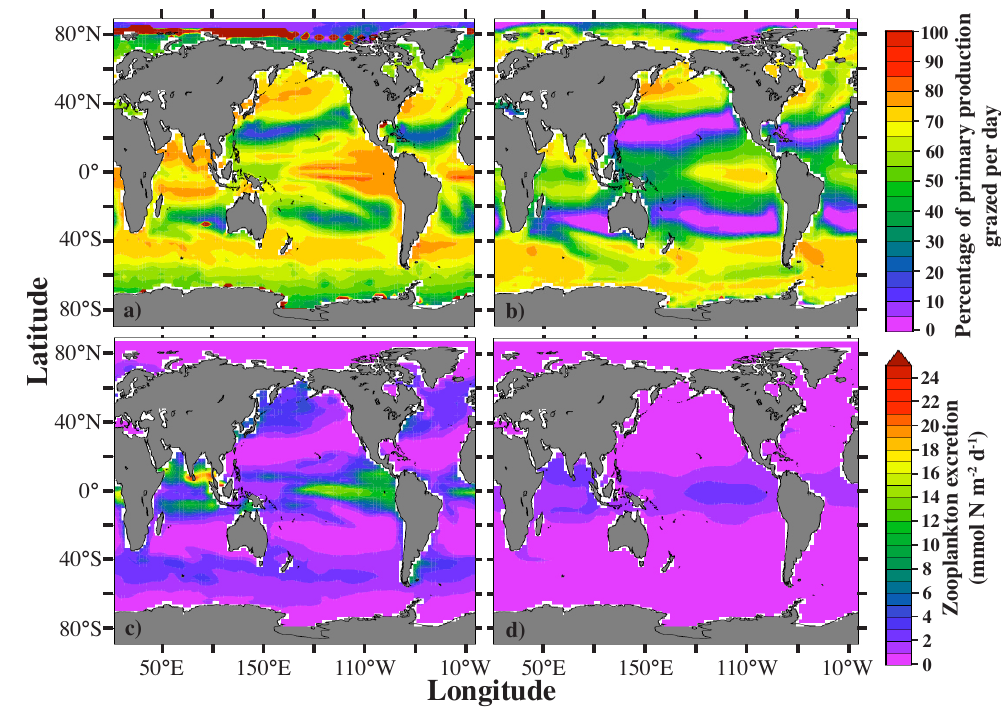
Fig. 24. Annual vertically integrated percentage of primary production grazed per day (top panels) and zooplankton excretion (bottom panels) with the ( a and c ) new and ( b and d ) old model